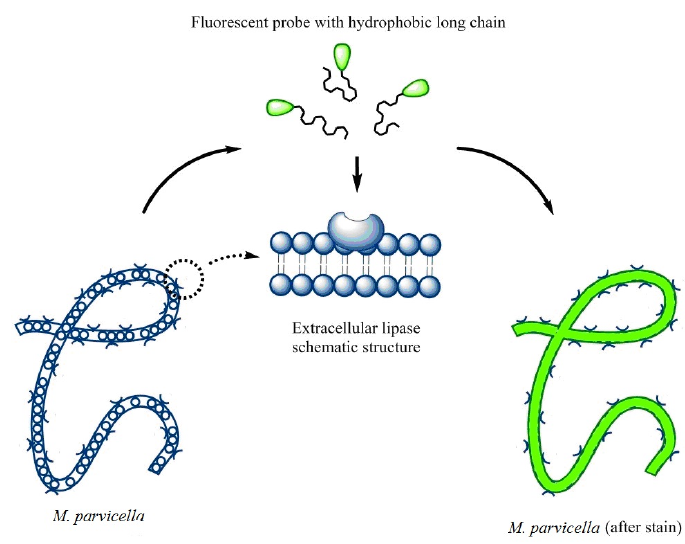
Figure 1. A schematic explaining the potential interactions between the fluorescent probe and M. parvicella filaments.